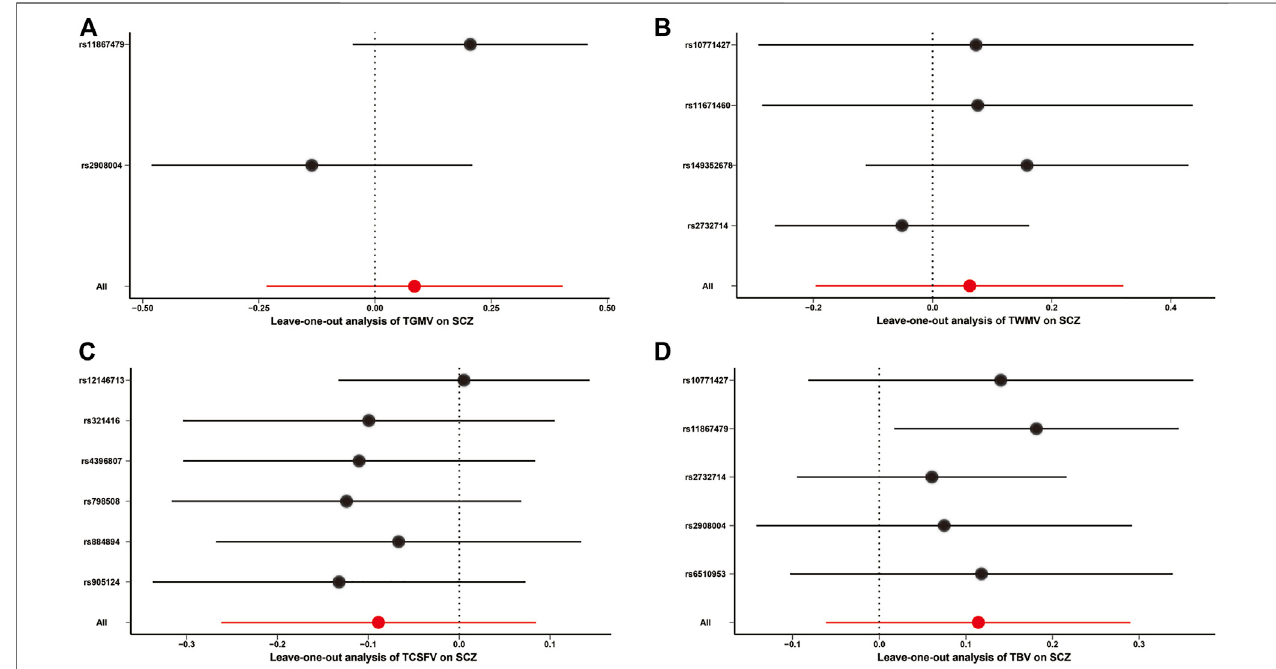
FIGURE2 | Leave-one-out analysisfor MR causality analysis between TBVMsand SCZ risk. (A) . Leave-one-out analysis for MR causality analysisbetween TGMV andSCZrisk. (B) .Leave-one-outanalysisforMRcausalityanalysisbetweenTWMVandSCZrisk. (C) .Leave-one-outanalysisforMRcausalityanalysisbetweenTCSFV and SCZ risk. (D) . Leave-one-out analysis for MR causality analysis between TBV and SCZ risk. The red points and red lines represent the BETA and 95% con fi dence intervalin MRanalyses,while the black points and blacklinesrepresent the BETA and 95%con fi dence interval after removingeach SNP sequentially. Ofnote,only theIVWmethod wasused intheleave-one-outsensitivityanalysis.Abbreviations:SCZ, Schizophrenia; TBV,totalbrainvolume; TCSFV,totalcerebrospinal fl uid volume; TGMV, total gray matter volume; TWMV, total white matter volume.